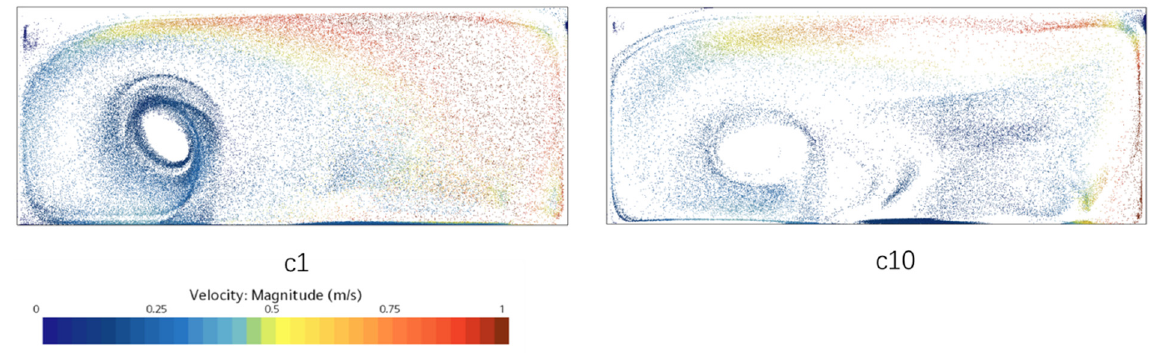
Figure 25. Location and velocity distribution of particles in c1 and c10.